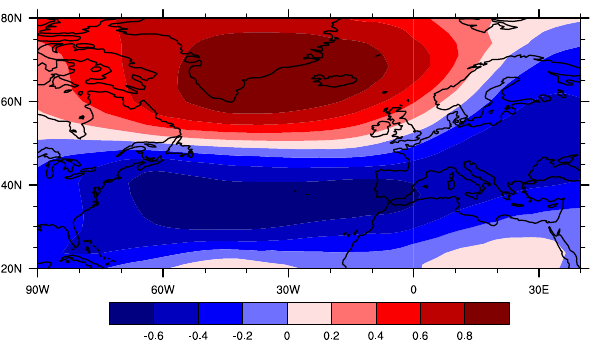
Fig. 3. One-point correlation map of model 500hPa geopoten- tial height for boreal winter (December-February) over the period 1960–2010. The reference point is 65 ◦ N, 30 ◦ W.